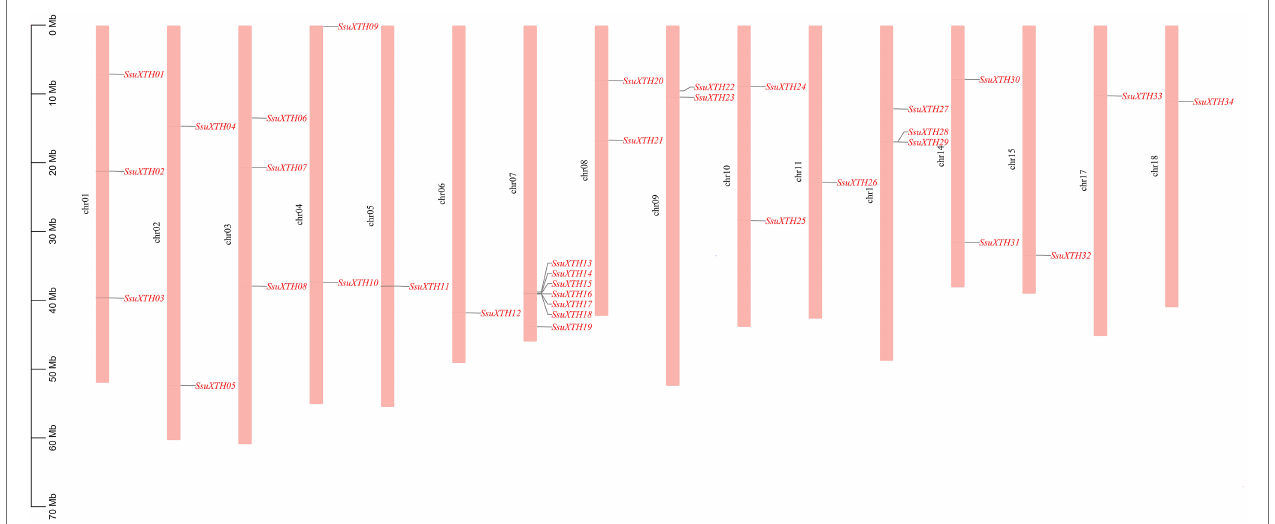
FIGURE 3 | The chromosomal distribution of SsuXTH genes. The left scale represents the length of the